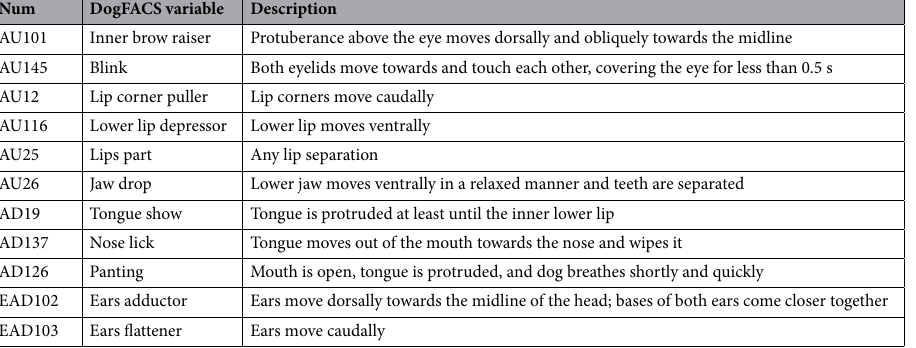
Table 1. DogFACS variables (Action Units (AUs), Action Descriptors (ADs) and Ear Action Descriptors (EADs)) used in 22 .